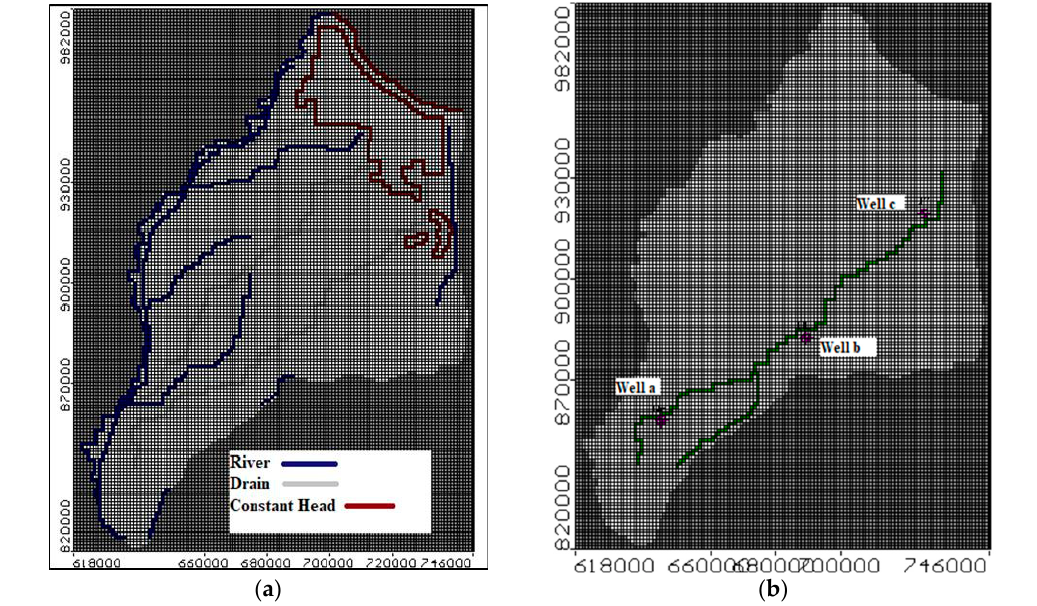
Figure 4. Boundary conditions of the ENDA: ( a ) head boundary conditions, ( b ) contaminant concentration boundary conditions and location of observation wells to evaluate COD concentration.